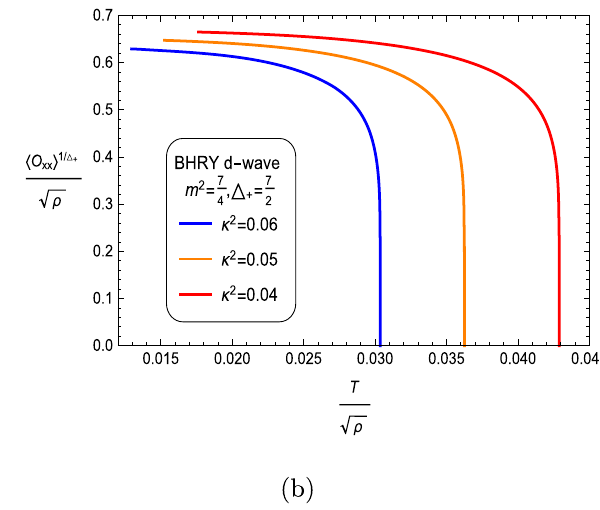
√ ρ = 0 . 0304 (blue: κ 2 = 0 . 06), √ / ρ = 0 . 0429 (red: c √ ∝ c